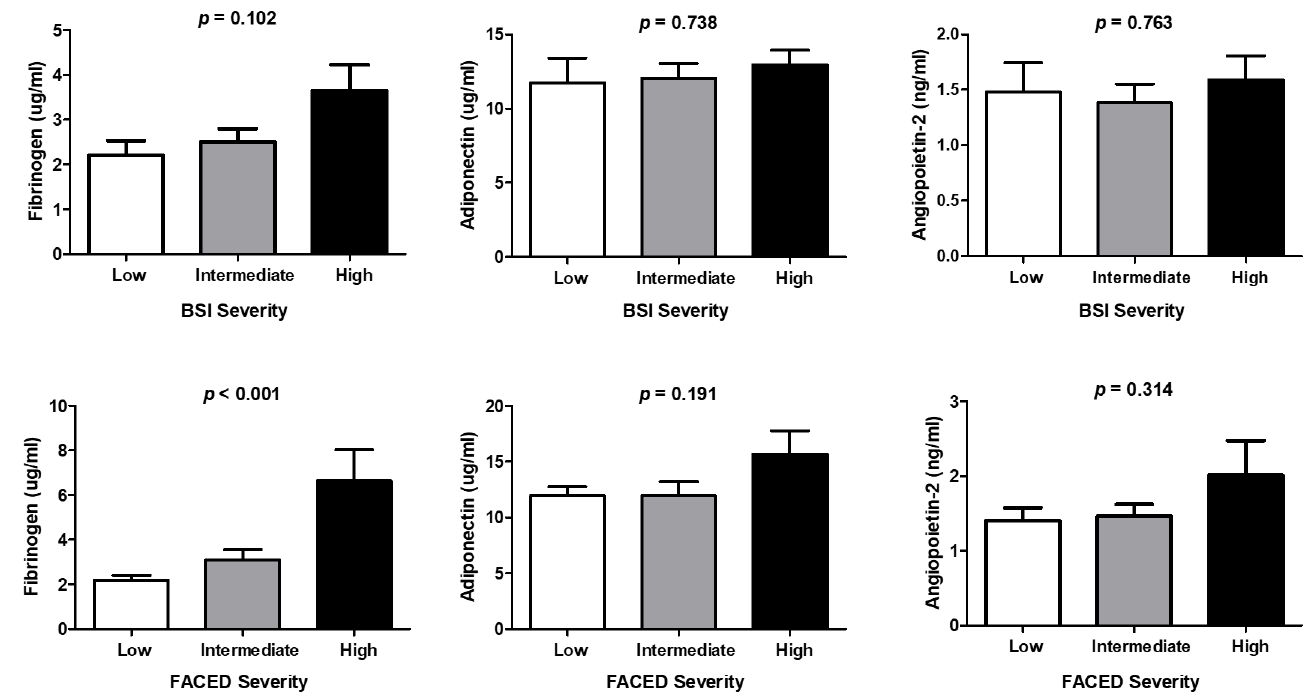
Figure 3. Levels of fibrinogen, adiponectin, and angiopoietin-2 across severity groups of BSI and FACED score. BSI: bronchiectasis severity index; FACED: FACED score.